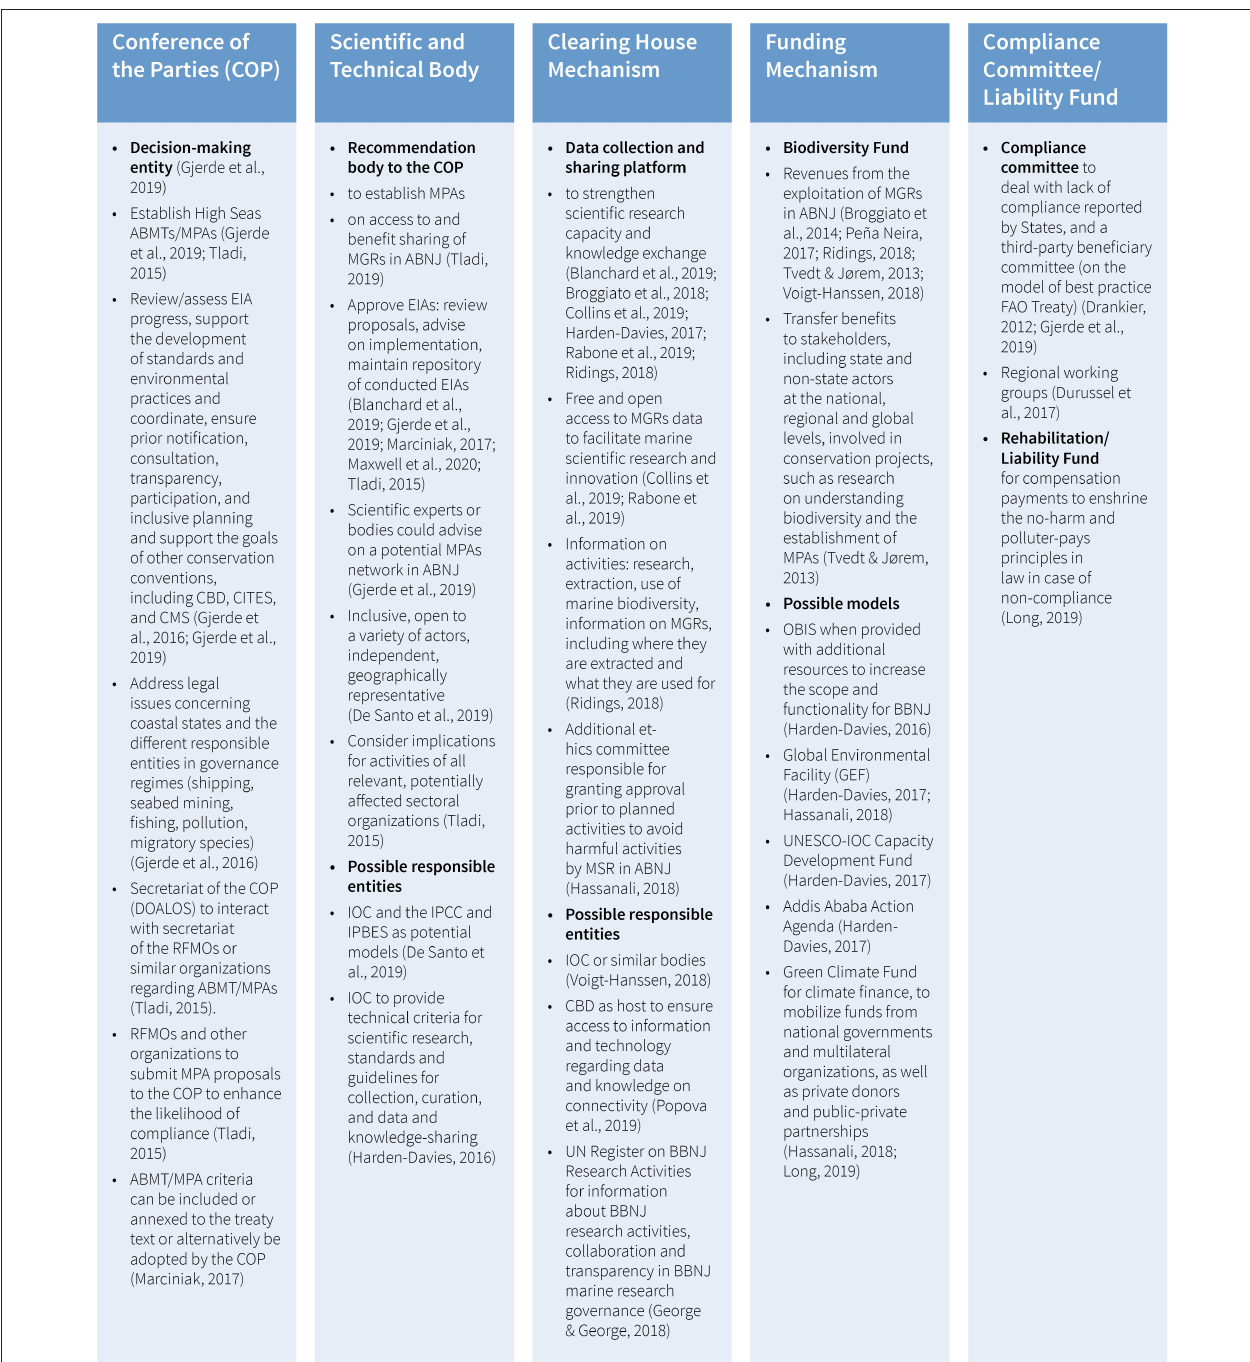
FIGURE 2 | Recommendations for institutional arrangements in BBNJ.